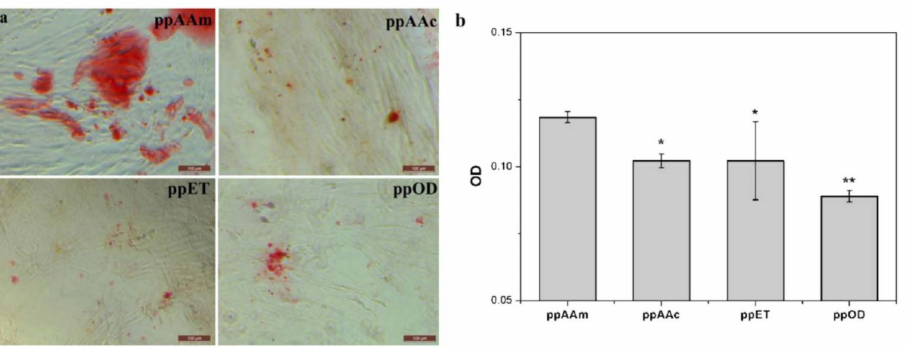
Figure 4. ( a ) Alizarin Red S staining for mineral deposition formed by hASCs cultured on different samples in medium with osteogenic supplement at day 14. ( b ) The quantitative result of retention of Alizarin Red. Data were expressed as means ± SD ( n = 4 for each sample). Single asterisk * and double asterisks ** denote a statistical significance of p < 0.05 and p < 0.01, respectively, compared with data obtained on the ppAAm sample. Reprinted with permission from [6]. Copyright (2014) American Chemical